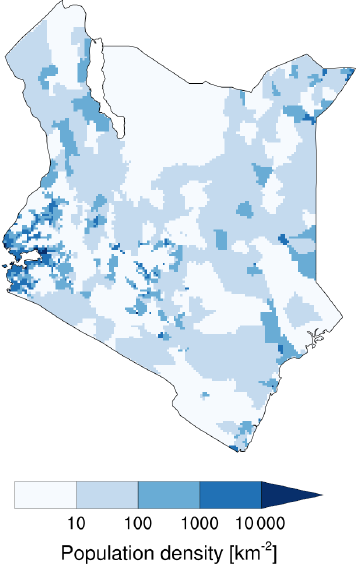
Figure 5. Ward-level density of the population exposed to 1-in-5- year flooding, produced by KRCS (see Sect. 2.2.2 for